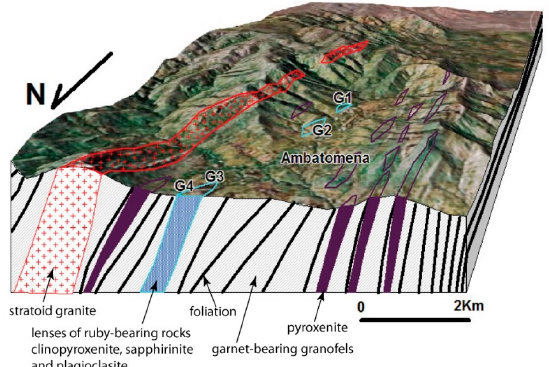
Figure 46. Panoramic view and geological cross-section of the Ambatomena ruby deposit, Betroka region, Southern Madagascar, modified from [243]. The correlation between the ruby-bearing